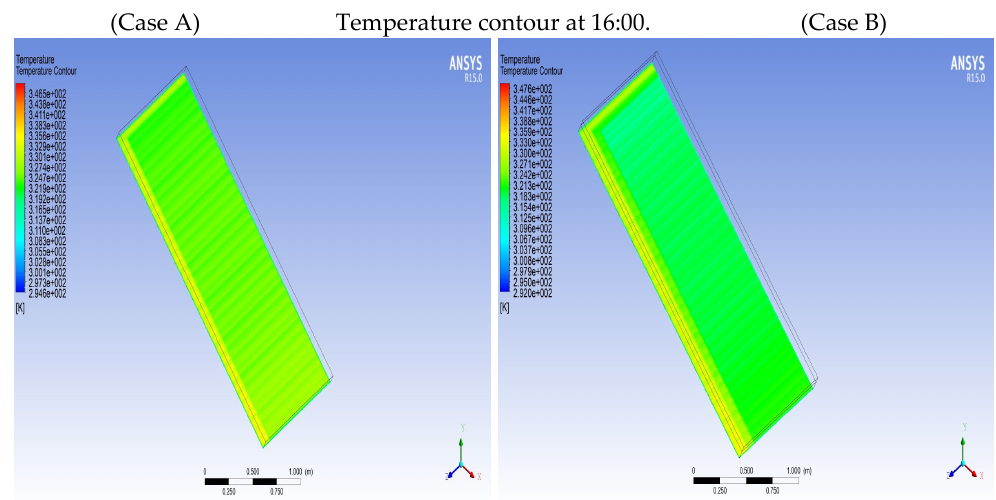
Figure 10. The absorber flat-plate temperature contours at various time intervals.